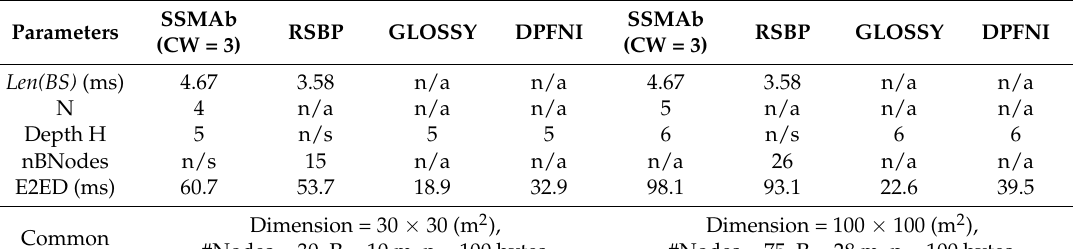
Table 3. Comparisons on the lower bound of